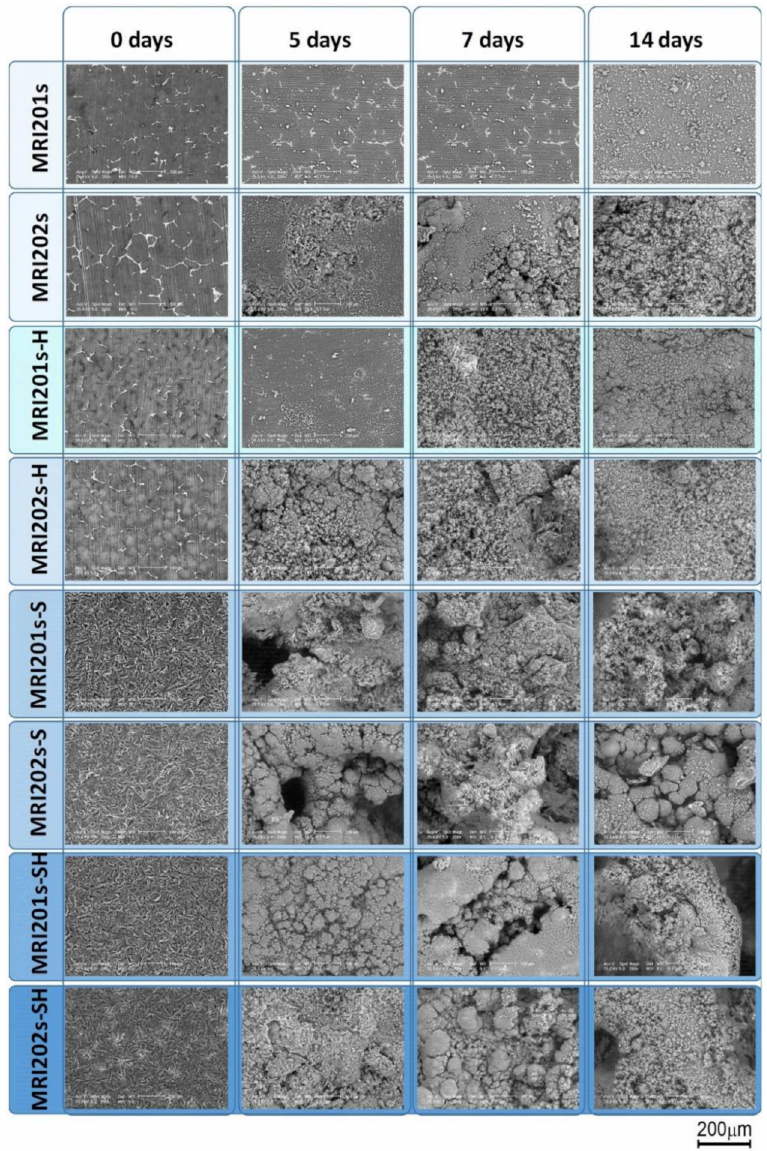
Figure 11. Surface morphologies of the experimental samples after 0, 5, 7 and 14 days of immersion in sodium chloride